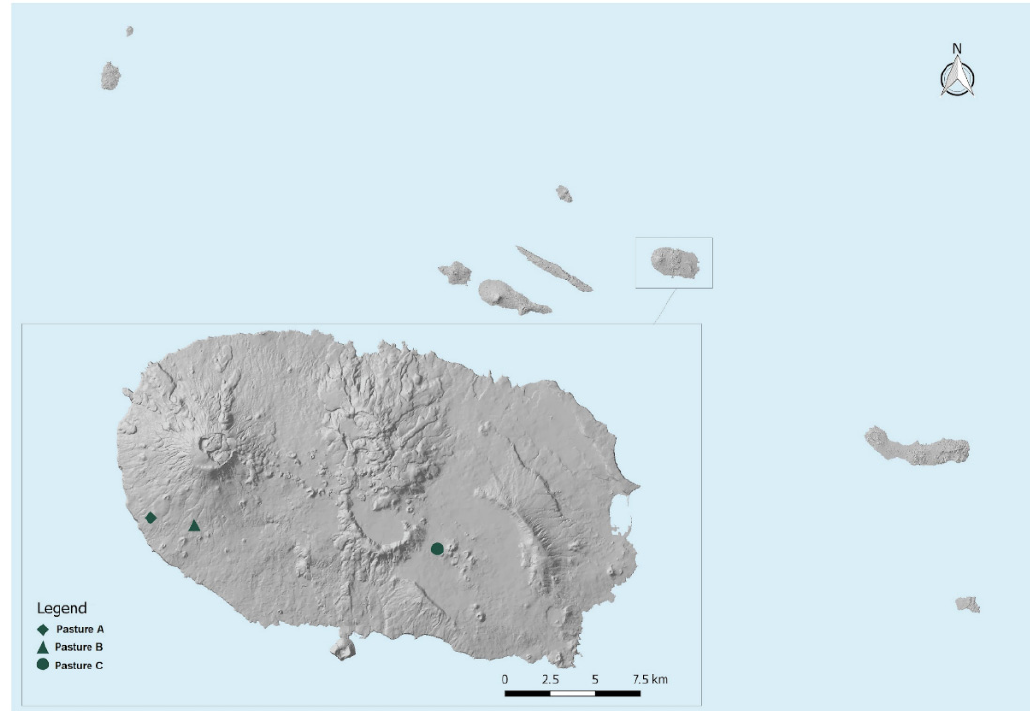
Figure 1. The island of Terceira in the Azores archipelago with the location of pastures A, B and C marked with three different symbols.